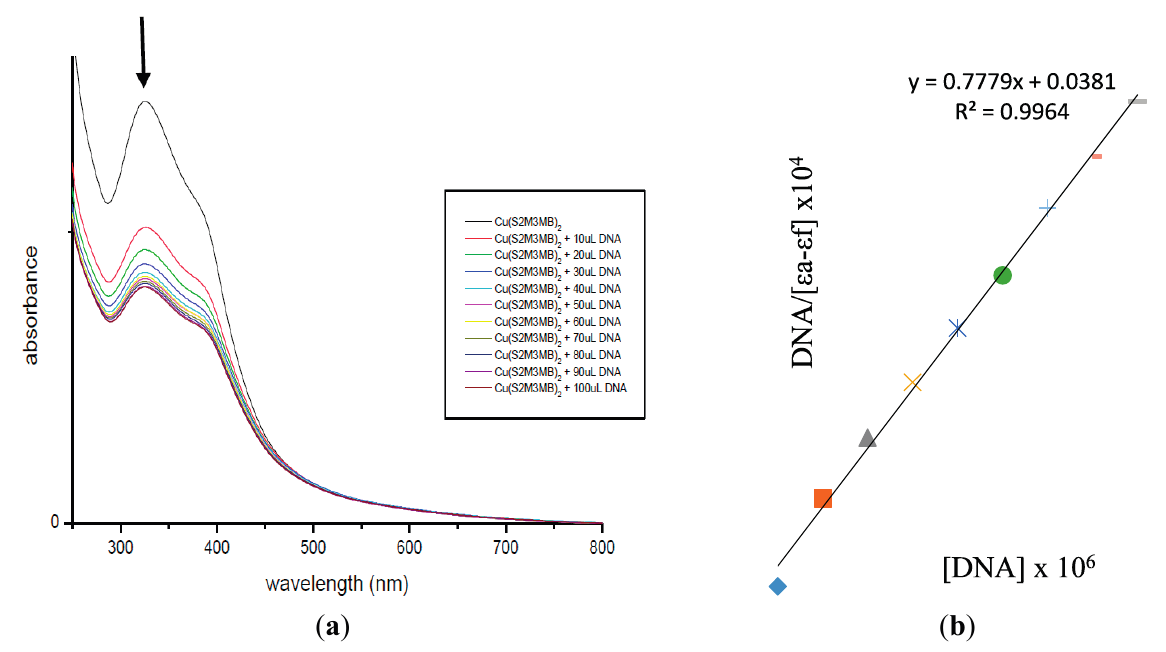
Figure 7. ( a ) Electronic absorption spectrum of 6 ; ( b ) Plot of [DNA]/ ε a −ε f vs. [DNA] for absorption titration of DNA with 6 . (The arrow indicates the change in absorbance in tandem with increasing DNA